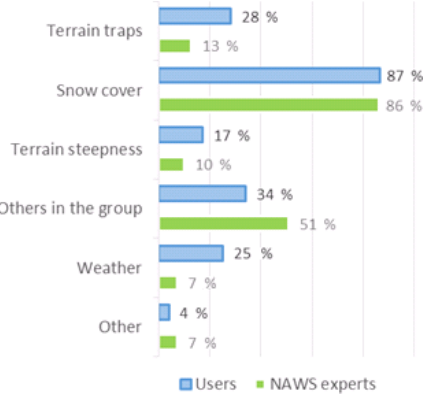
Figure 4. Factors users and NAWS experts considered difficult to assess and manage in order to have a safe trip in avalanche